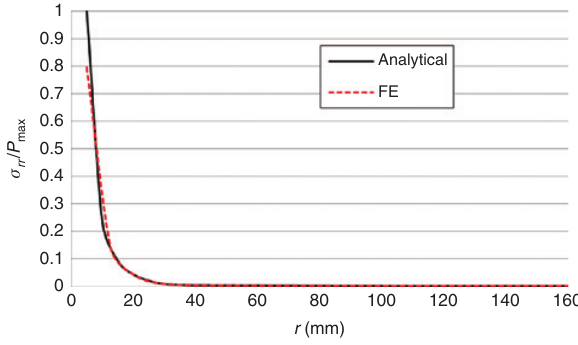
Figure 5: Radial variations of the modulus of elasticity through the inner cylinder, the FG inter-layer, and the surrounding plate in six investigated models.